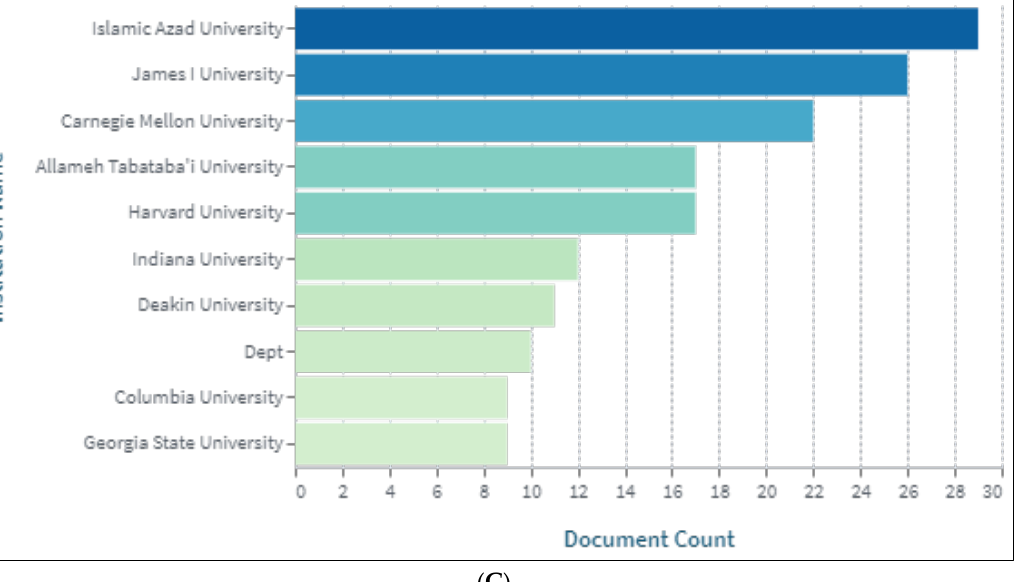
Figure 3. Pragmatic language development knowledge production size by university: ( A ) Scopus; ( B ) WOS; ( C ) Lens.